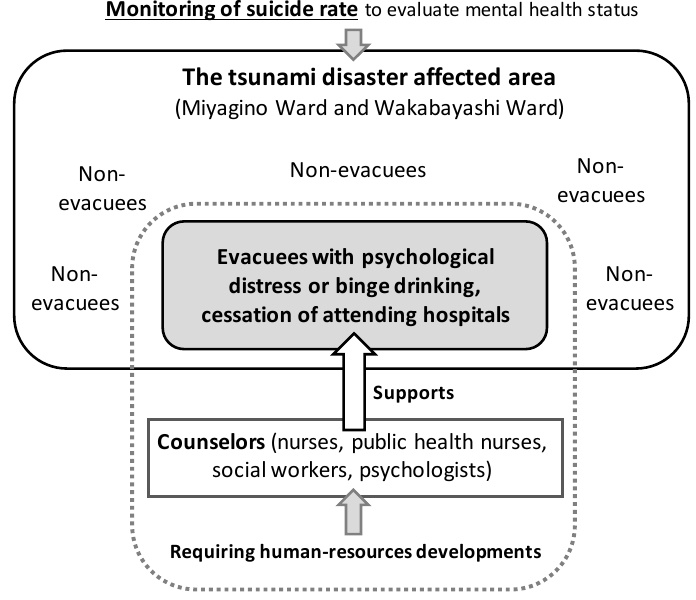
Figure 3. Practical activities of disaster-related mental health interventions.